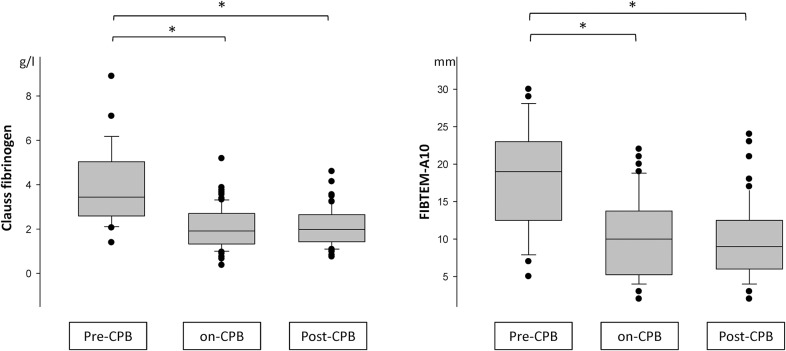
Clauss fibrinogen and A10 in relation to CPB.Boxplot, median, 25th/75th percentile; whiskers, 10th/90th percentile; extremes. A10, A10. *) denotes significant (p < 0.05) change between times of measurement.